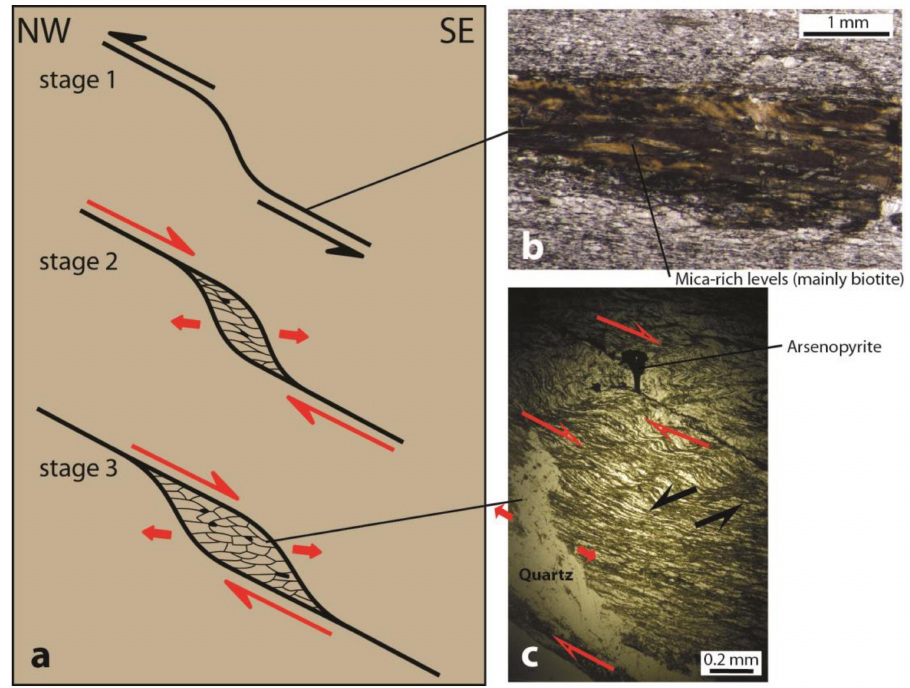
Figure 6. ( a ) Formation of sigmoid vein during late-orogenic collapse tectonics (red arrows) within the Quadril á tero Ferr í fero (Minas Gerais, Brazil). Note that vein re-used an early level formed by mica alignment related to the nappe emplacement ( b ). The sigmoidal shape reflects thrust-related emplacement (black arrows). Extensional pull-apart post-dated thrust-related structures and controlled gold-bearing quartz-sulphide veins ( c